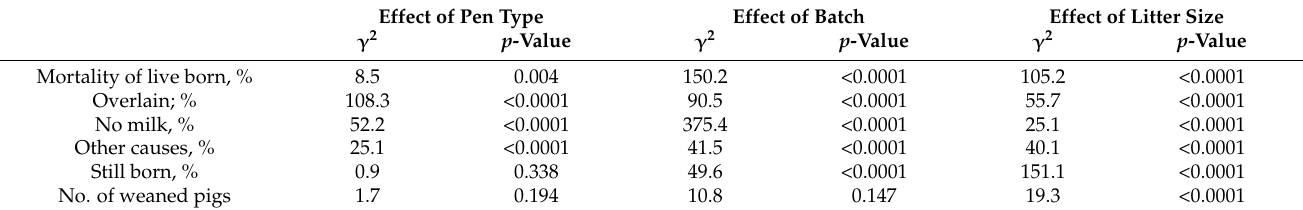
Table 3. Effects of pen type, batch (3 batches with TRAD-traditional: n = 156 L and 7 batches with SOWCOMF: n = 343 L) and litter size on piglet mortality in farm 2. Except for stillborn which was given in % of total born piglets and number of weaned pigs, the other variables were given as % of live born piglets.